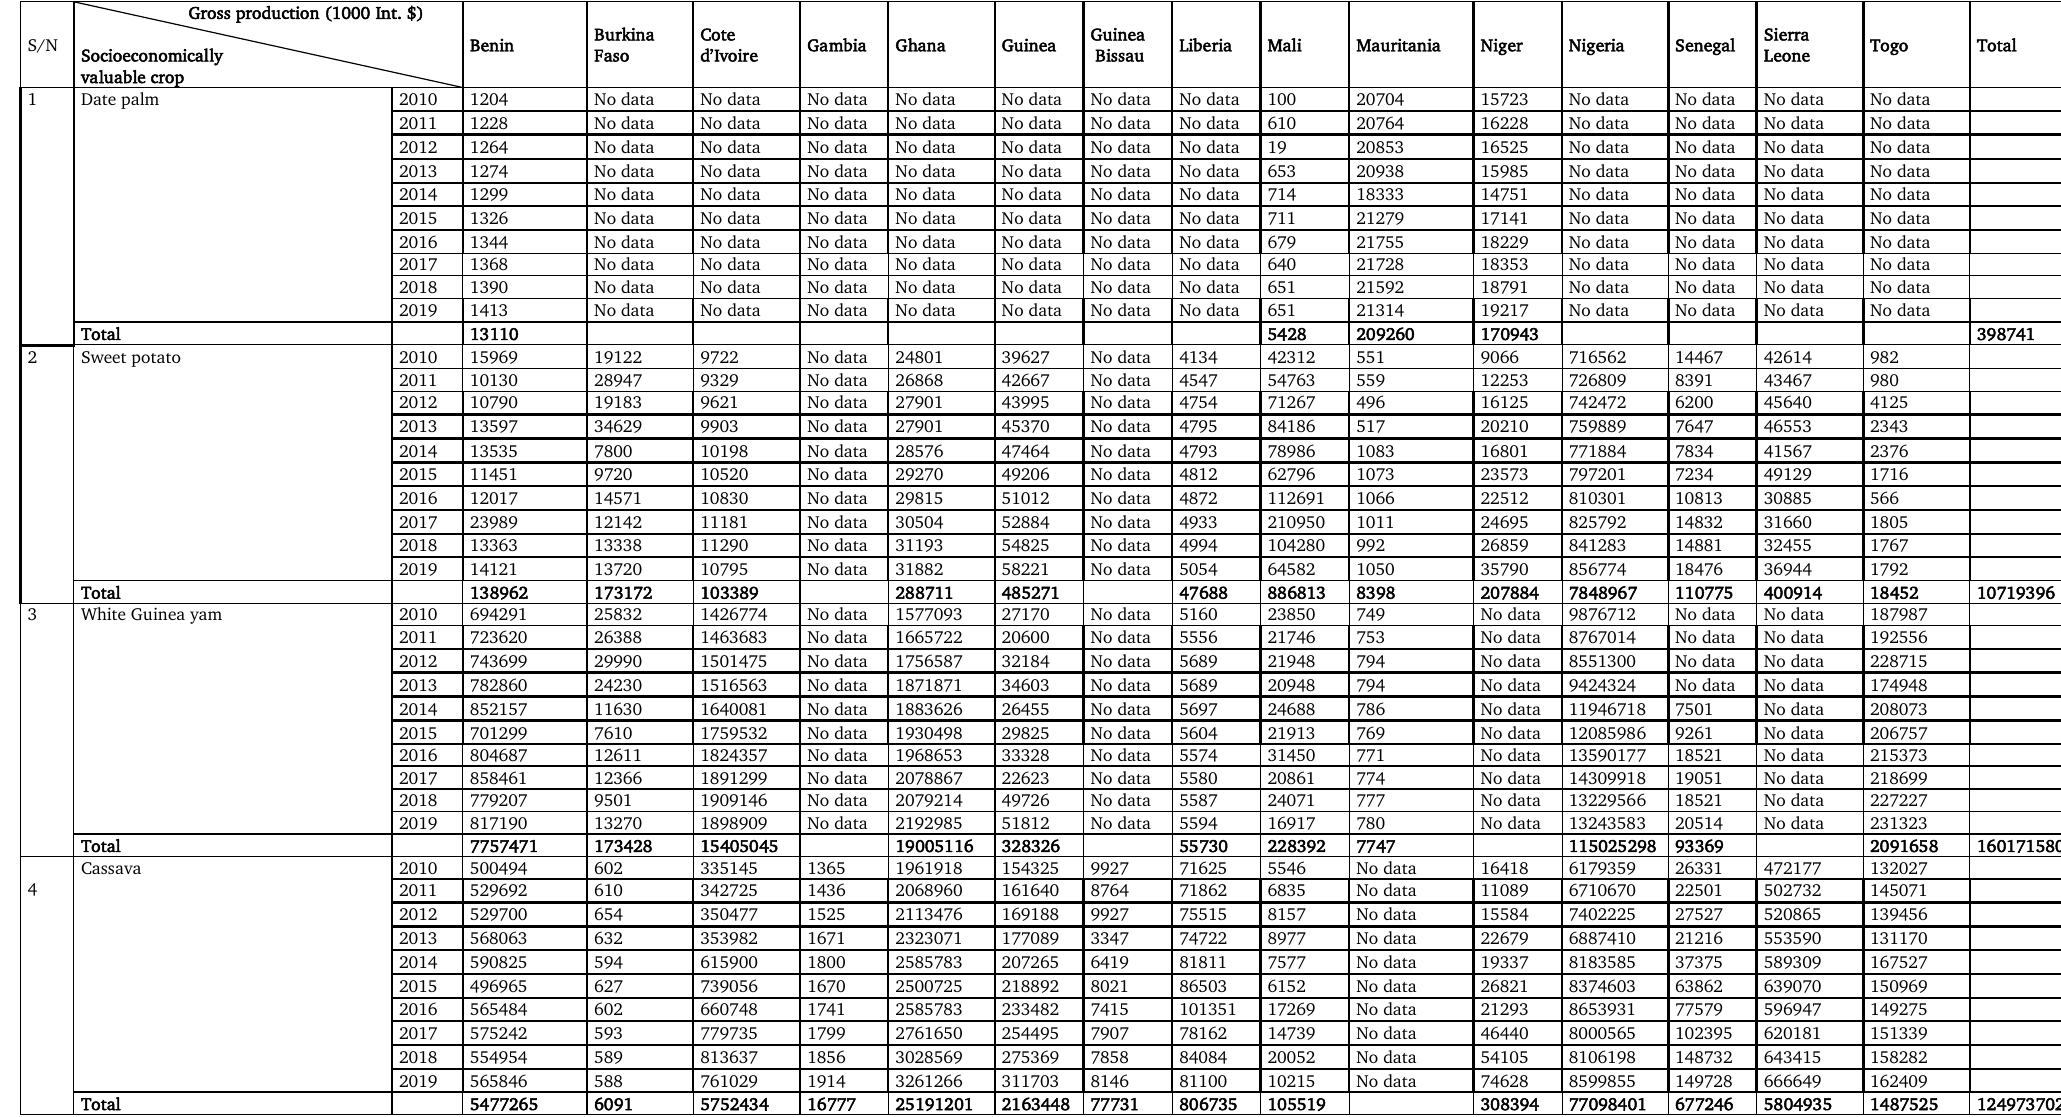
Supplemental Table S3: Gross production value of socioeconomically valuable crops in West Africa Gross production (1000 Int. $) S/N Socioeconomically valuable